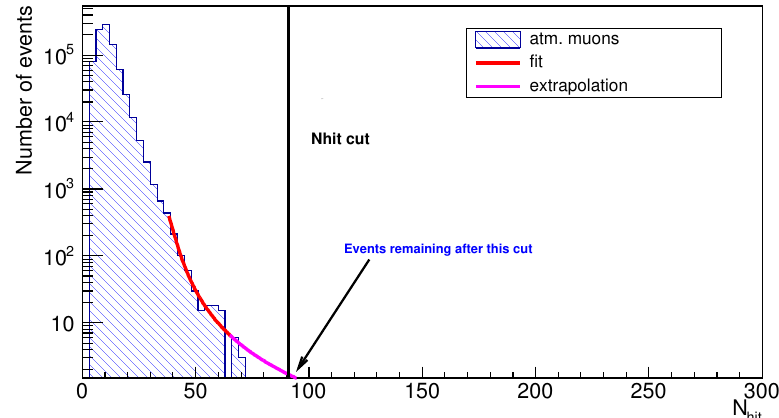
Figure 7 . The distribution of N hit for atmospheric muons, extrapolated using a Landau (cid:12)t function. The contribution of the extrapolation in the total number of events was taken into account in the optimization and the extrapolation uncertainties were computed. For this bin (cid:12) = [0 : 8170 ; 0 : 8615], 1.4 events are found after the cut N hit >